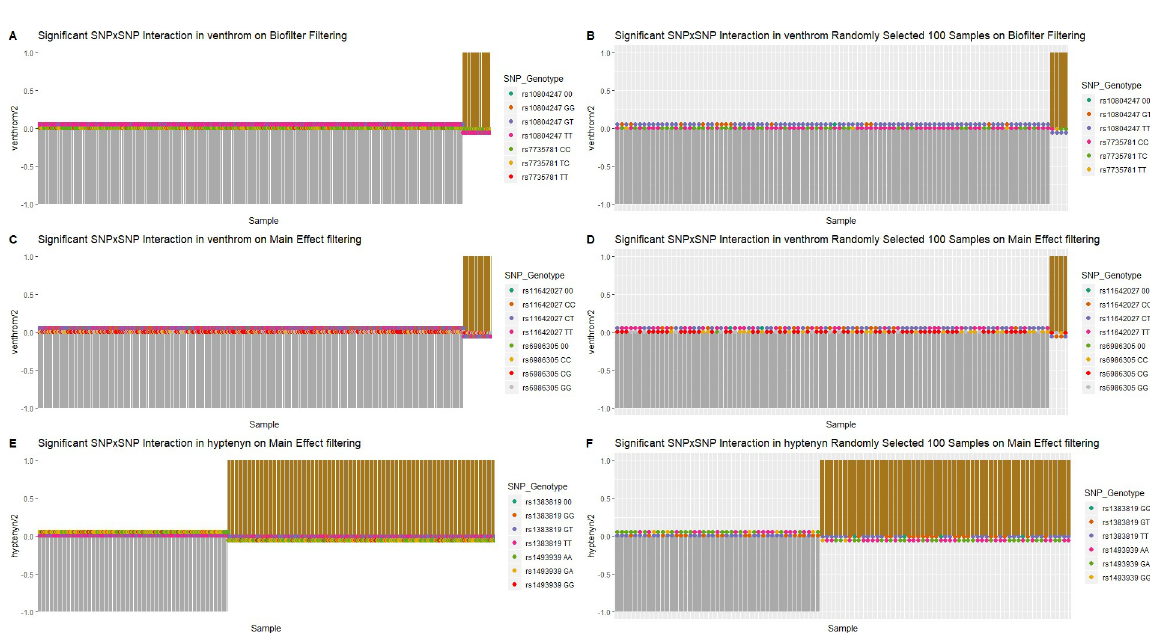
Fig 5. Distribution of phenotype and genotype for the top interactions in cardiac traits under different filtering methods. Individuals with cardiac trait were assigned “1” and individuals without cardiac trait were assigned as “-1”. The distribution of cardiac trait status and corresponding genotype for SNPs for the top interactions were plotted for A) rs10804247-rs7735781 for the patients with venous thrombosis or pulmonary embolism under Biofilter filtering, C) rs11642027-rs6986305 for the patients with venous thrombosis or pulmonary embolism under main effect filtering, and E) rs1383819-rs1493939 in for the patients with the history of hypertension under main effect filtering. The randomly selected 100 individuals were also plotted for each top interaction (B, D, F).